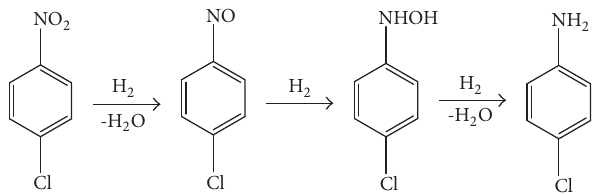
Scheme 1: Resumed reaction pathway for the hydrogenation of p-CNB.